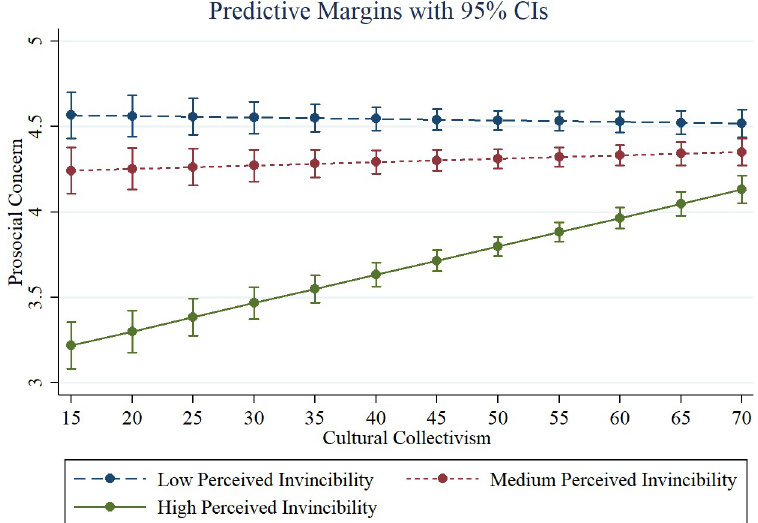
Fig 1. Predicted prosocial concern by perceived invincibility and cultural collectivism. Fig 1 uses linear mixed methods results from Table 1 Column (2).